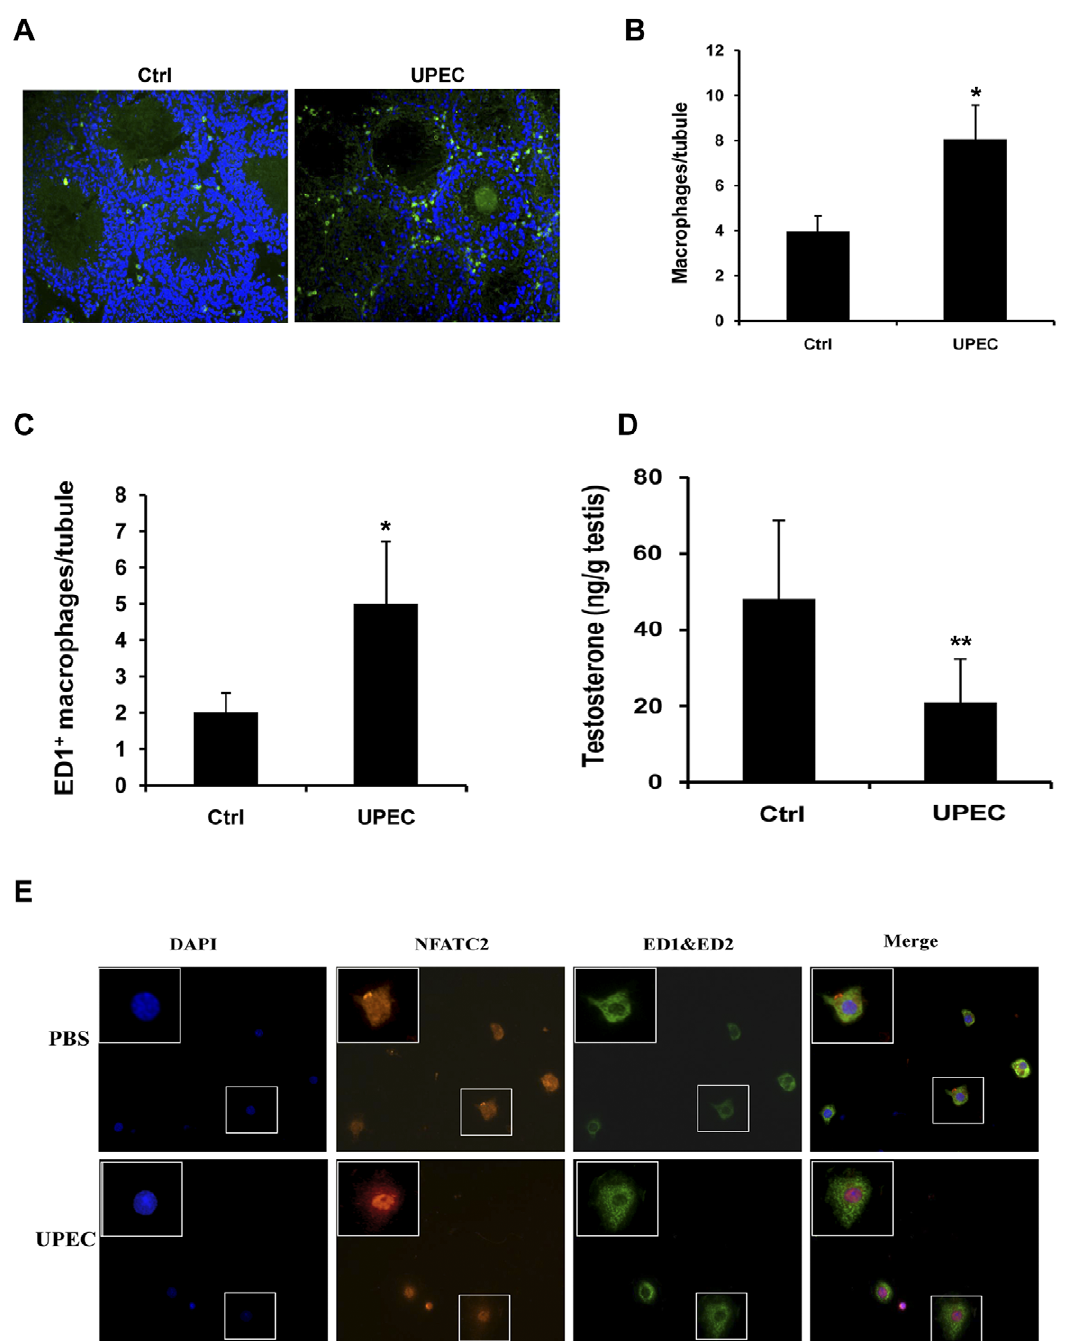
Figure 8. Bacterial orchitis elicited by invivo infection with UPEC CFT073. Infection resulted in an increased number of ( A, B ) ED1 + ED2 + total testicular macrophages and ( C ) ED1 + ‘inflammatory’ macrophages. Immunolabeled macrophages were counted in whole cross-sections and related to the number of cross-sectioned seminiferous tubules in the same section visualized by DAPI stain. ( D ) Testosterone concentrations were measured by RIA in testicular homogenates of testis obtained from animals 7 days post UPEC infection into the vas deferens and PBS injected sham operated rats (Ctrl). Testosterone concentrations are significantly lower in orchitis compared to sham-operated animals. ( E ) In TM isolated from testis 7 days post UPEC infection in the vas deferens, NFATC2 showed a nuclear localization. In contrast, NFATC2 is found in the cytoplasm of TM obtained from testis of PBS injected sham operated rats (Ctrl). Nuclei are counterstained with DAPI (blue). Inserts show a higher magnification of a cell seen in the respective overview. Macrophage quantification: values are means 6 SD of n= 2 (Ctrl), n=4 (UPEC). Testosterone measurements: values are means 6 SD of Ctrl (n=8); UPEC (n=10). Statistical analysis was performed using student t-test. *=p , 0.05, **=p , 0.01.